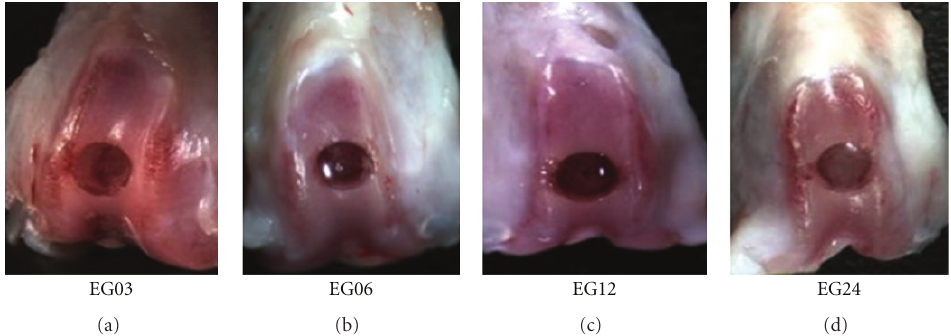
Figure 6: EGs stereoscopic images. Maintenance of PVA aspect and of adjacent cartilage can be observed, furthermore there was an absence of neoformed tissue surrounding the implant and no PVA implant collapse. Magnification 10x.